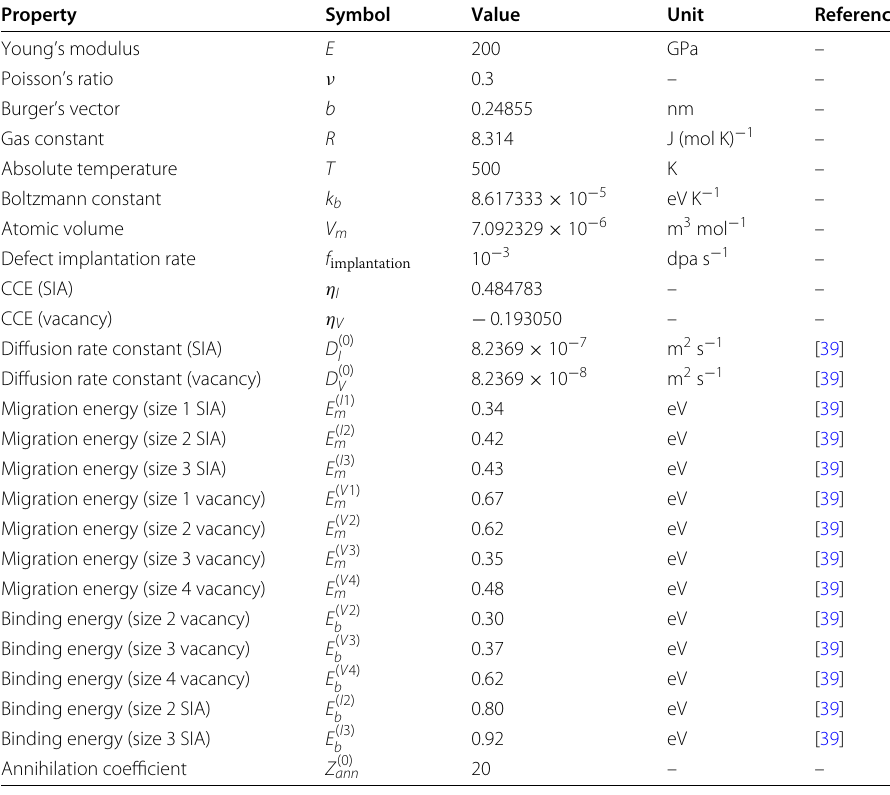
Table4 Mechanical constants and parameters used for diffusion simulations Property Symbol Value Unit Reference Young’s modulus Poisson’s ratio Burger’s